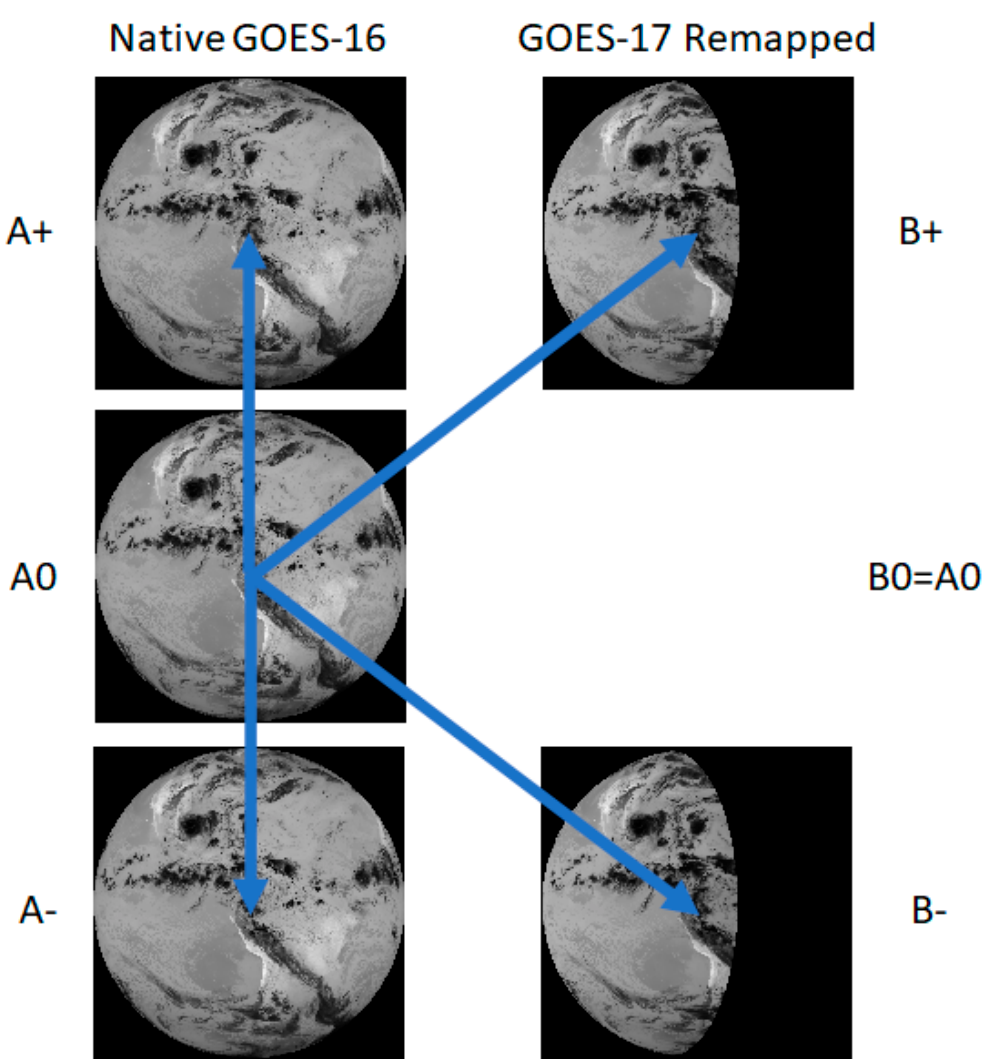
Figure 2. The GEO–GEO stereo-wind approach uses three A satellite repetitions and two B satellite repetitions. All repetitions of the A scenes must be the same scene type and the same for the B satellite; however, A and B may be a different scene types (e.g., Continental U.S. (CONUS) for A and full disk (FD) for B). In this case, GOES-16 is the A satellite and -17 is the B satellite. The GOES-17 FDs have been remapped into the fixed grid of GOES-16 leaving an area to the east where no remapped pixels could be constructed since they are over the GOES-17 horizon. Band 14 radiances are shown with an arrow to indicate matching for feature tracking with all templates taken from the A0 scene.